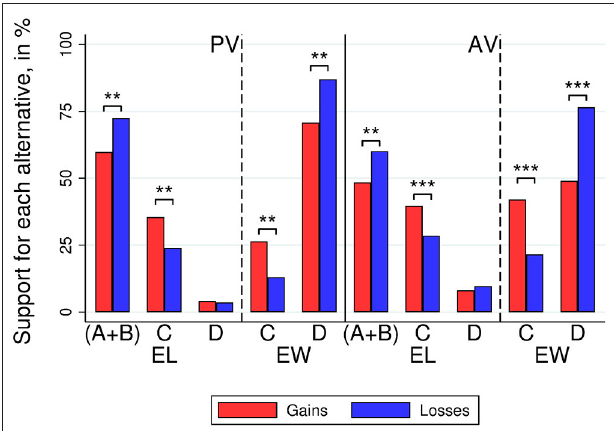
FIGURE 1 | Society 1. Voter support for the different alternatives by treatment (gains vs. losses), voting method [plurality voting (PV) and approval voting (AV)], and voter group (Efficiency Winners and Efficiency Losers). A and B are the self-interested alternatives players of types I and II, respectively. Alternative C assigns equal payoffs to all voters, and D is a socially-efficient alternative. Stars refer to the significance of non-parametric tests ( ∗∗ p < 0.01 ∗∗∗ p <